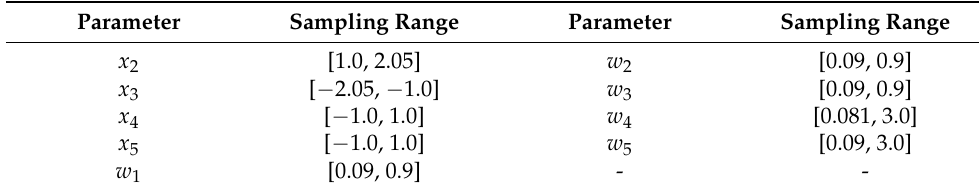
Table 3. Parameters’ sampling range.